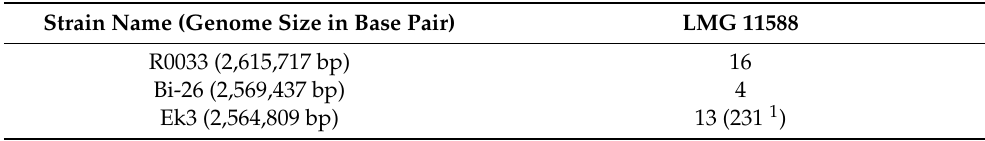
Table 3. Number of SNPs found between the B. infantis LMG 11588 sequenced strain and closely related publicly available genomes (ANI >